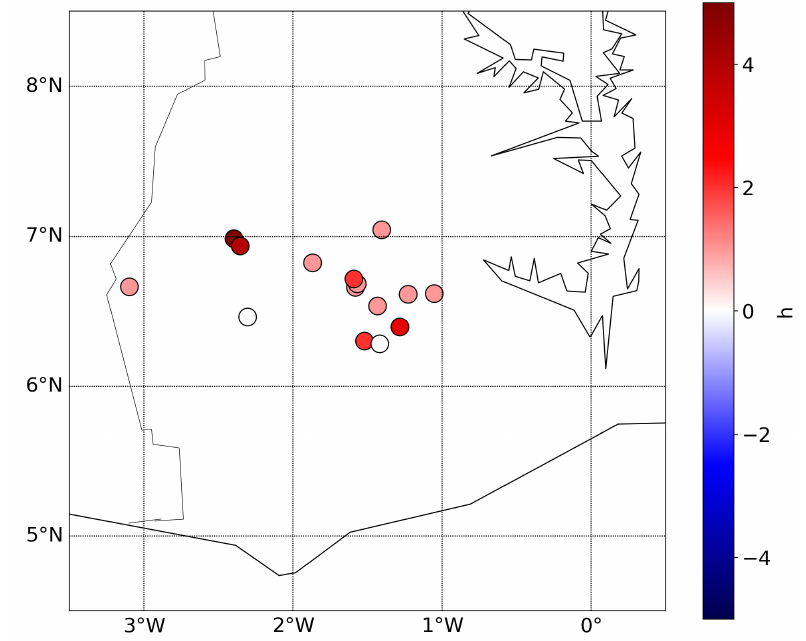
Figure 17. Timing error before spatial warping at each station (only at stations that recorded >0.1 mm/h). In red, the peak in u is late (compared to the one in the station measure- ment). In blue, the peak in u is in advance. It has to be noted that the timing error can only be given at the hourly resolution due to the definition of the time